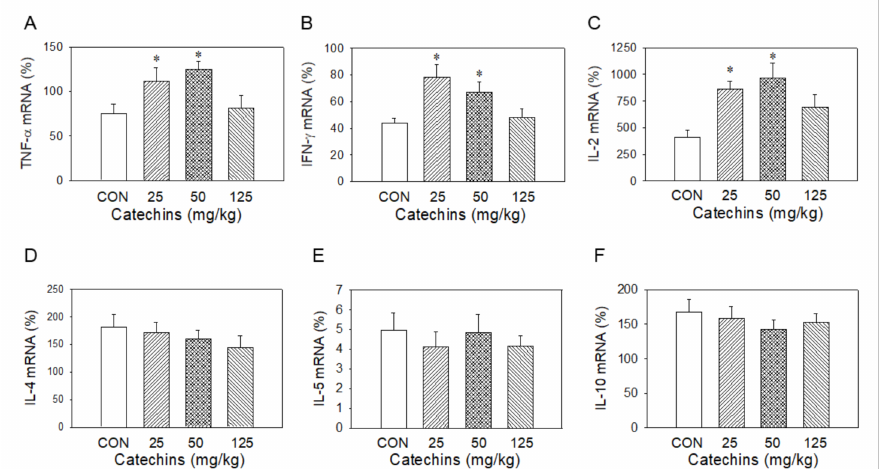
Figure 6. Four-week catechins ingestion significantly increased splenic mRNA expression of type I cytokine TNF- α ( A ), IFN- γ ( B ) and IL-2 ( C ), but had no effect on type II cytokine mRNA IL-4 ( D ), IL-5 ( E ), and IL-10 ( F ); * p < 0.05 vs. control group (0 mg/kg).